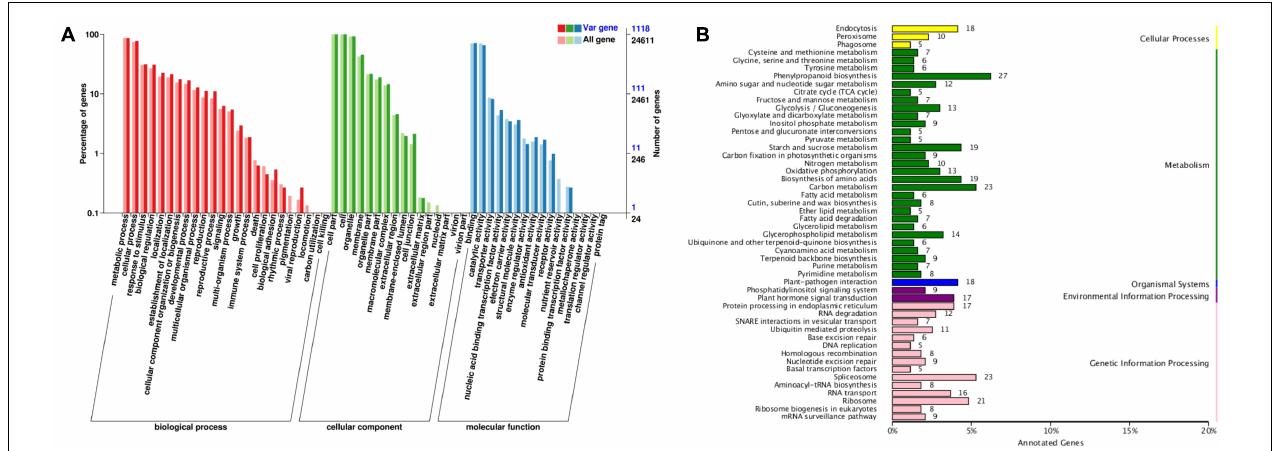
FIGURE 5 | Functional annotations of 2,486 genes identified in selective sweep regions of cultivated broomcorn millet genome. (A) Annotation based on GO database. The left Y -axis indicates the proportion of genes in the three main categories of GO classification and the right Y -axis indicates the number of genes in each category. “All gene” represent all genes in the GO database and “Var gene” represent the selected genes annotated to the GO database. (B) Annotation based on KEGG database. The Y -axis indicates the top 50 metabolic pathways, the X -axis indicates the numbers of genes annotated to the pathways and its proportion to the total number of genes